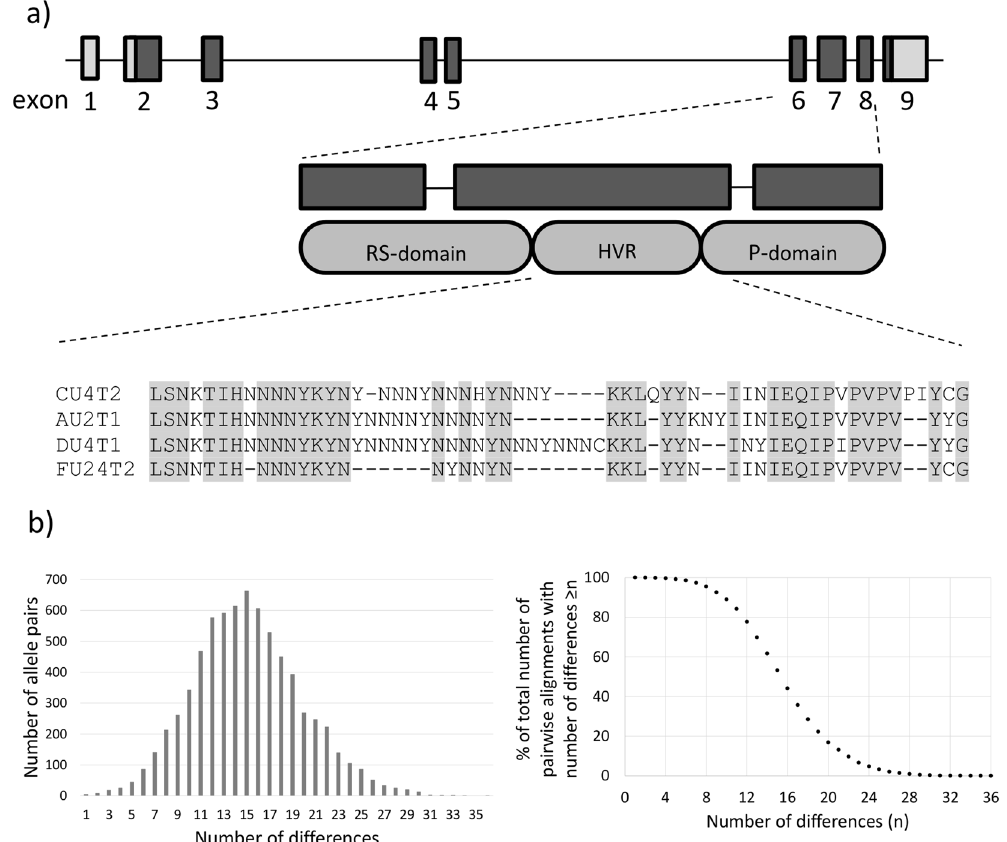
Figure 1. Apis mellifera csd locus. ( a ) Schematic representation of the Apis mellifera csd locus and the location of the elements that encode the potential specifying domain (PSD) containing: arginine/serine-rich domain (RS-domain), hypervariable region (HVR) and proline-rich domain (P-domain). A representative alignment of the HVR for four csd sequences is shown. The range of the analysed csd sequence is marked. ( b ) Distribution of the number of differences observed between every two csd sequences that were obtained during a pairwise alignment of all the 121 non-identical csd sequences, which were identified in Population AB (left diagram), and the fraction of the total number of pairwise alignments with the number of differences ≥ n (right